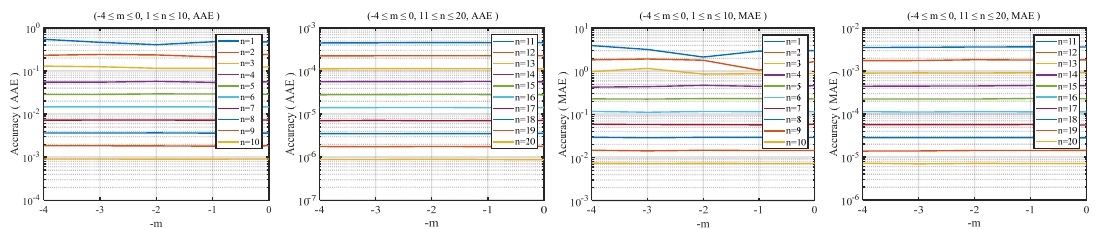
Figure 3. RHC: Accuracy distribution corresponding to different m